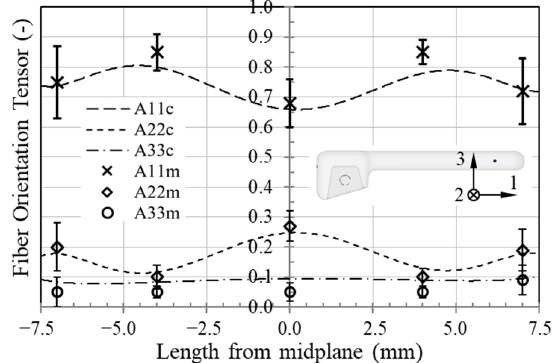
Figure 6. Explanation of measurement of fibre orientation in a section of one fibre, based on [16], ( a ) Figure 7. Validation of fibre orientation across the thickness, 10 mm from the end of product (“c”— and one measured optical microscope image ( b ). calculated data with AMI; “m”—measured data according to optical microscopy with standard de- viation).